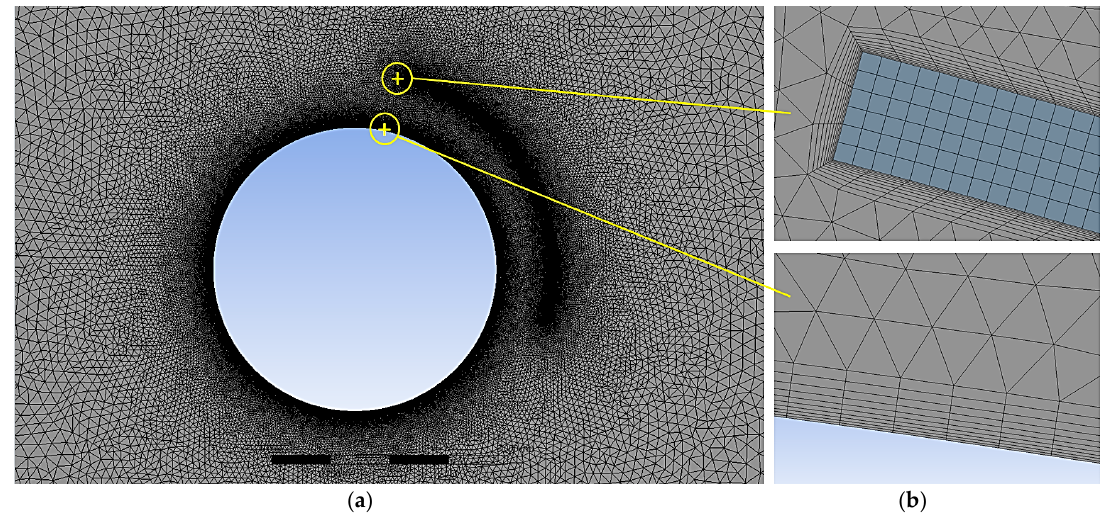
Figure 3. ( a ) Meshed study domain in the ANSYS meshing tool; ( b ) grid pattern near the kiln and absorber wall. Table 1. Grid independence study for the unsteady solution (main problem).